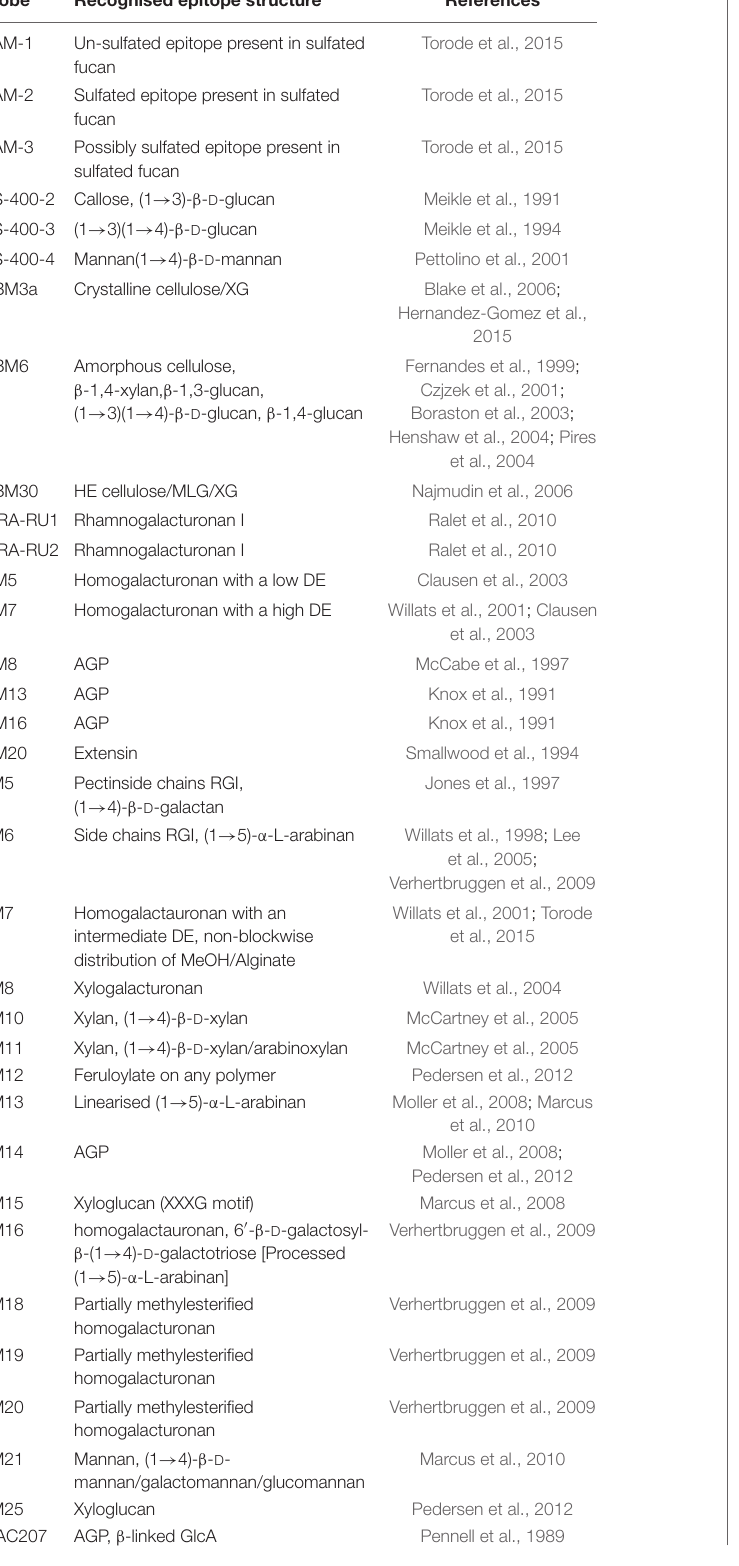
TABLE 2 | Specificities of the probes used in this study, organized in alphabetical order. Probe Recognised epitope